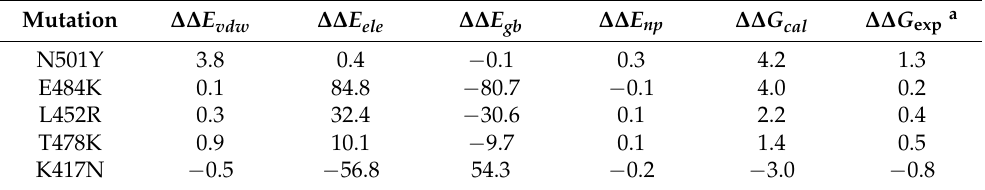
Table 2. Calculated binding energy differences between specific single point mutants and the wild- type SARS-CoV-2 S protein in binding to ACE2 by the ASGB method. The energy values are in